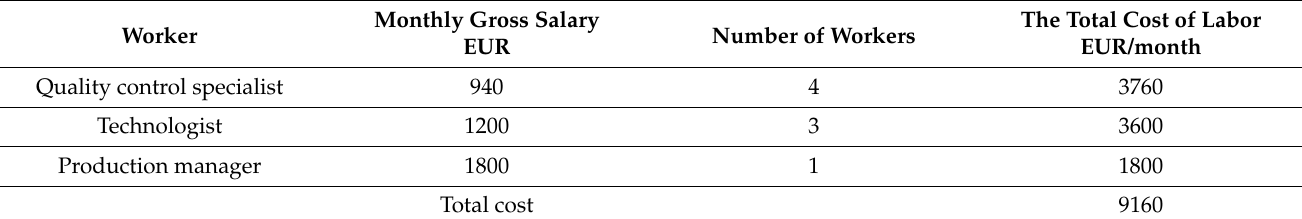
Table 8. Labor costs of people [EUR/month]. Average monthly gross salaries are based on annual calculations of the Polish Central Statistical Office 2022